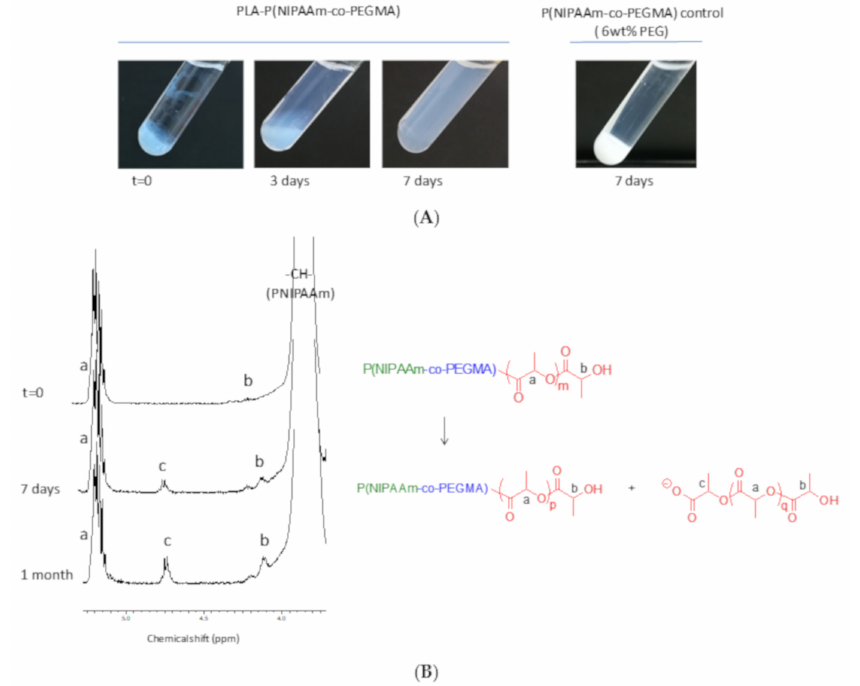
Figure 5. In vitro degradation (PBS, pH 7.4, 37 ◦ C) of PLA-P(NIPAAm-PEGMA) hydrogel, assessed visually ( A , photographs) and quantitatively ( B , 1 H NMR in deuterated dimethyl sulfoxide